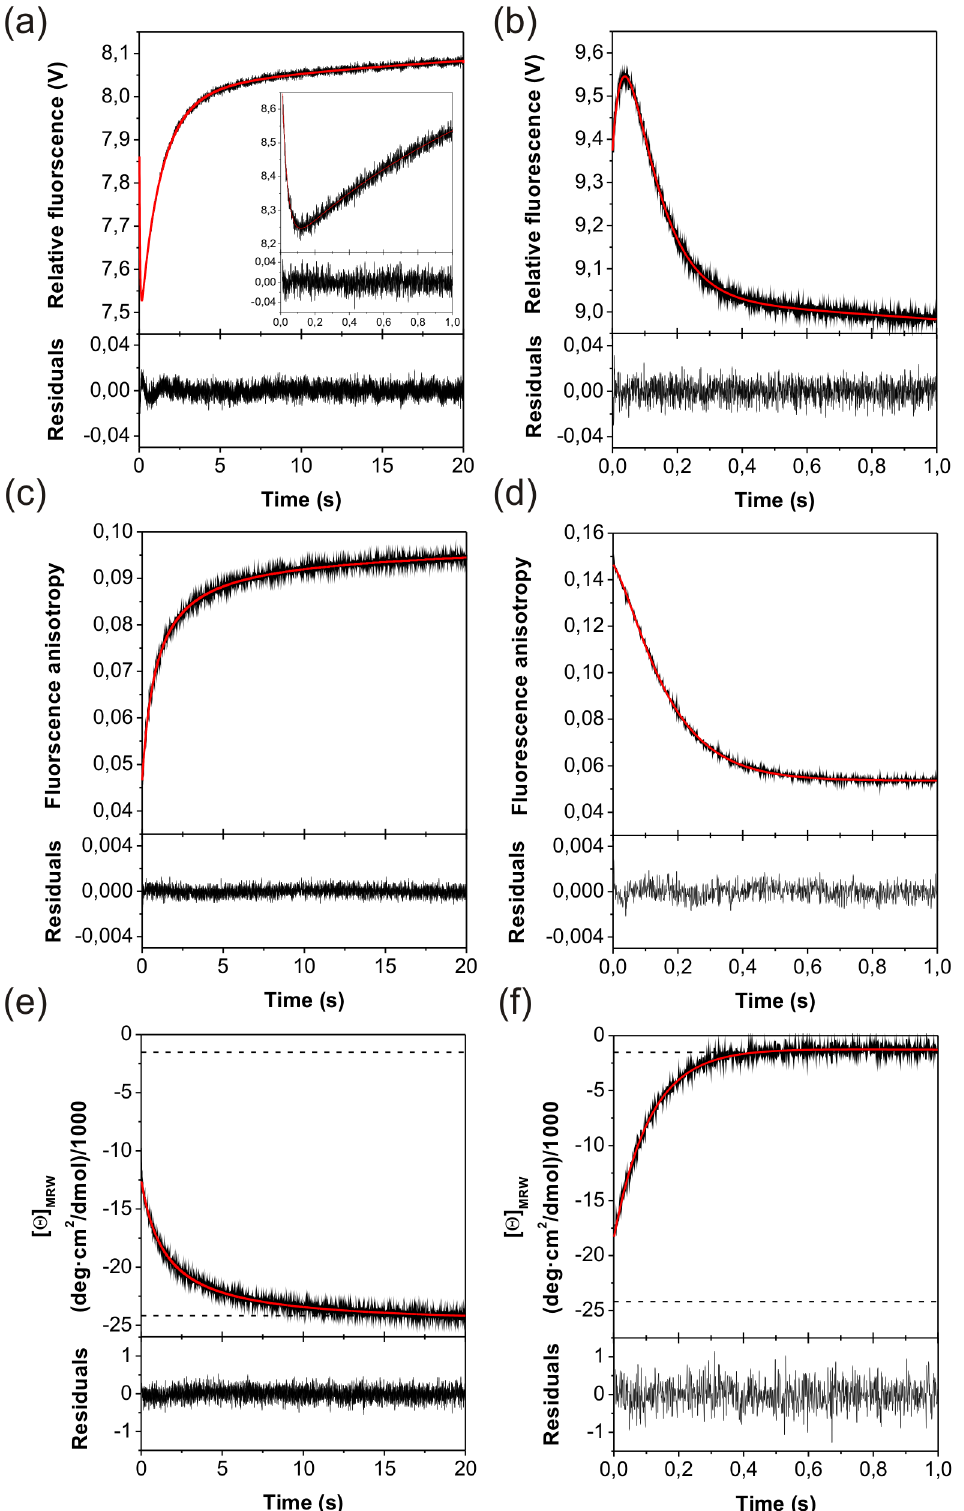
Fig 3. Single-mixing refolding and unfolding kinetics of N-BAR. The kinetics were monitored (a) and (b) by fluorescence, (c) and (d) by fluorescence anisotropy, (e) and (f) by far-UV CD. Refolding (a, c, e) was initiated by rapid dilution of unfolded protein in 4 M urea to 0.4 M urea. Unfolding (b, d, f) was